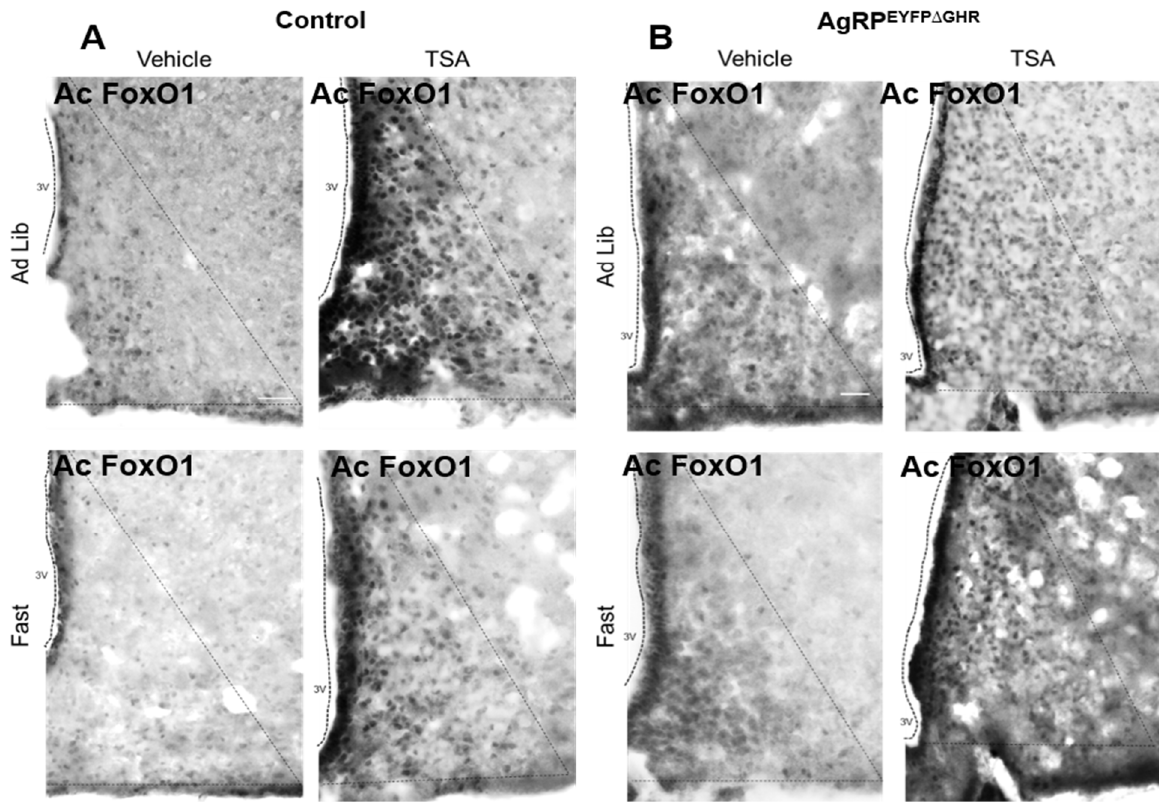
Figure 4. Trichostatin A (TSA) treatment induces forkhead transcription factor (FoxO1) acetylation. Acetylated FoxO1 expression in the ARC of fed and 18-h-fasted female mice. ( A ) The 8–12-week-old female control, and ( B ) AgRP EYFP Δ GHR mice were injected with TSA or vehicle into the 3V (Intracerebroventricular: icv). Representative photomicrographs from 3–4 sections per group were pseudo-colored in grayscale. Scale bar: 100 µm. The 3V, third ventricle.